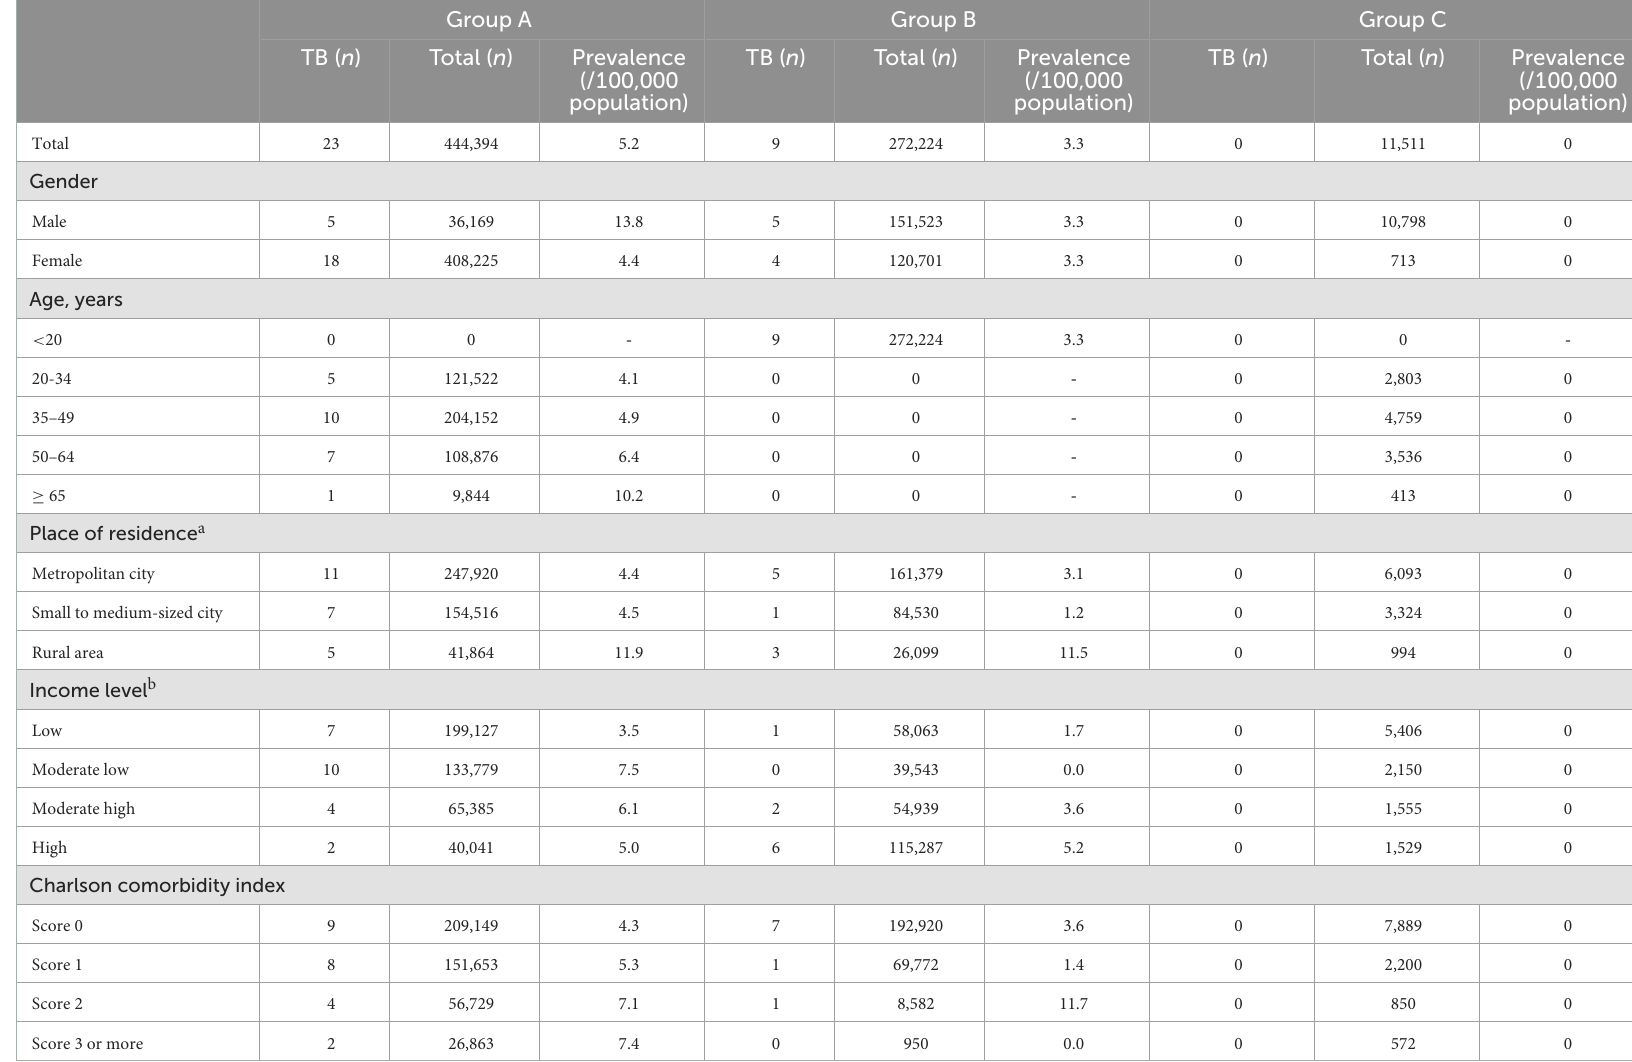
TABLE 1 Prevalence of concurrent active TB among the total participants in each group.